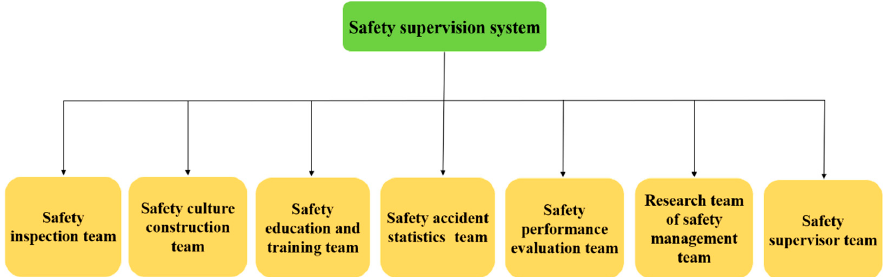
Figure 2. The proposed organizational structure of the safety supervision department.